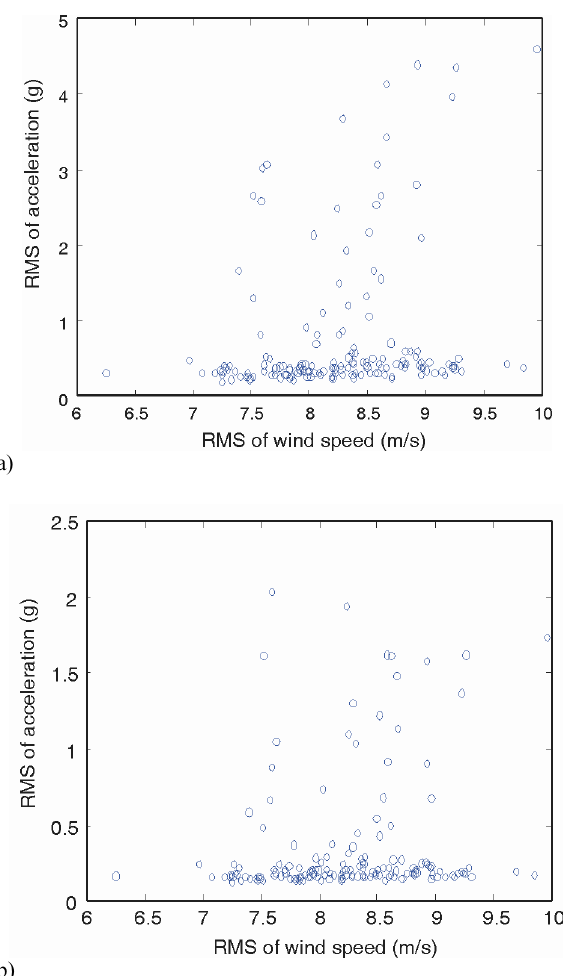
Fig. 5. Correlation between RMS of deck level wind fluctua- tions and RMS of A12 cable accelerations: (a) In-plane accele- ration (16:51–17:51, 1 April 2003); (b) Out-of-plane accelera- tion (16:51–17:51, 1 April